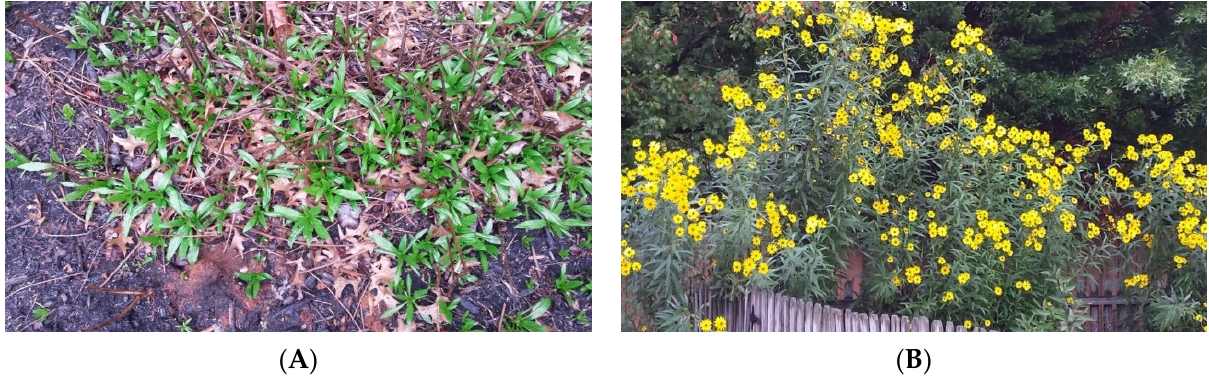
Figure 1. Growing habit of Helianthus verticillatus . ( A ). Basal rosettes of H. verticillatus in February. The dried stalks are from the previous year. ( B ). Flowering on tall stalks of H. verticillatus in late September when the plant produces attractive, yellow inflorescences.